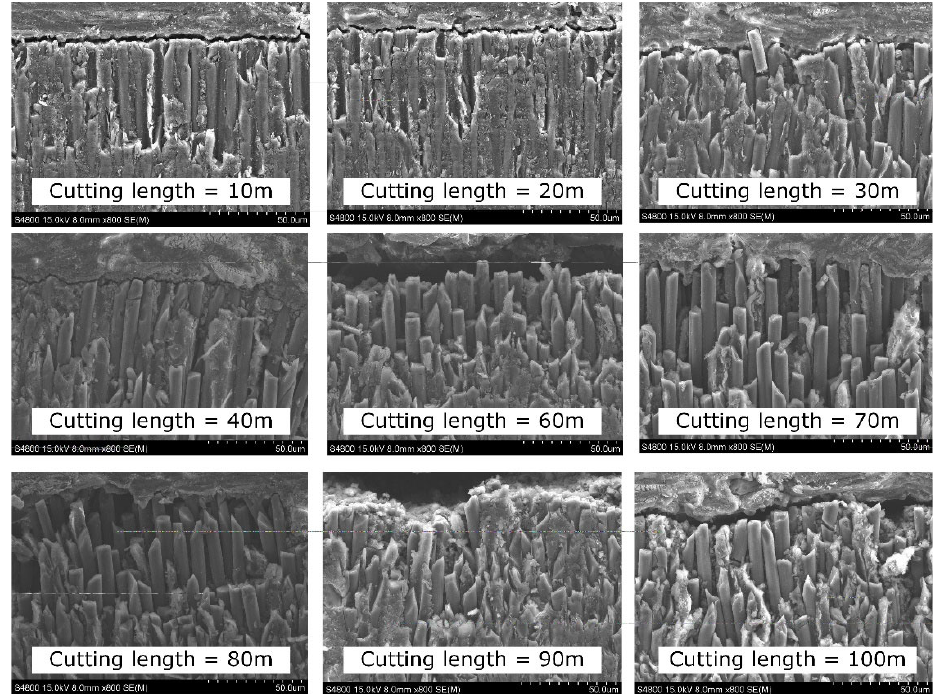
Figure 5. CFRPs subsurface at different cutting lengths.